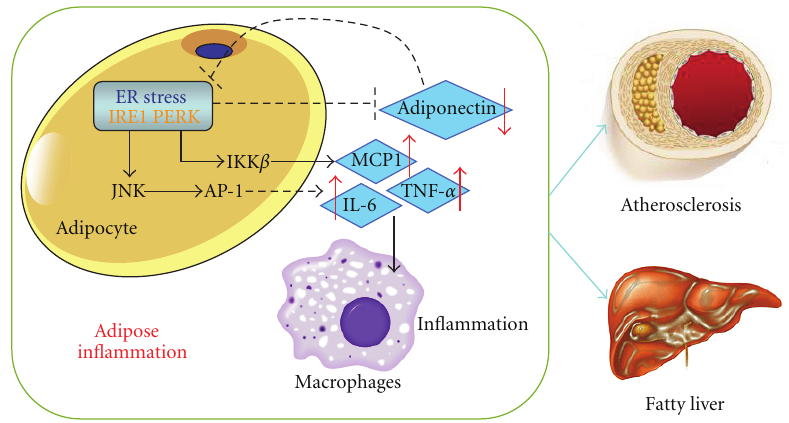
Figure 2: ER-stress-induced inflammation in adipocytes and macrophages contributes to atherosclerosis and fatty liver diseases.